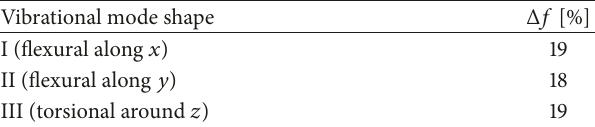
Table 3: Shear design value at the base of the building.